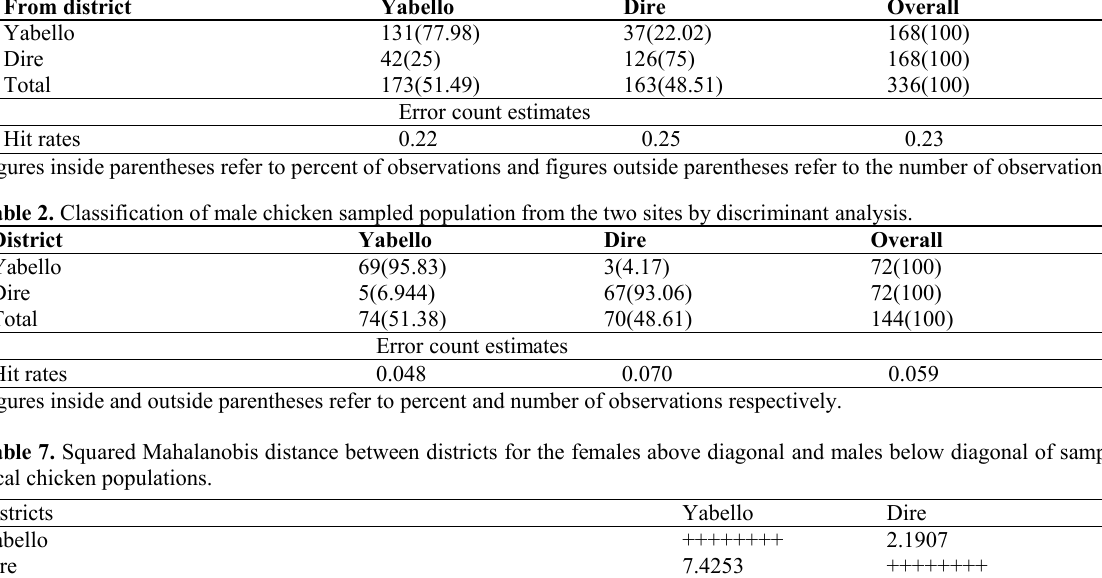
CL CH 1.00 Where; **and * correlation indicate significance level at (P<0.01 and 0.05) respectively, WS= wing span; BW= body weight; BL = body length; ChC = chest circumference; NL = neck length; BAL = back length; WL = wattle length; WD = wattle depth; CL =comb length; CH = comb height. Table 5. Classification of female chicken sampled population from the two sites by Discriminant analysis. From district Yabello